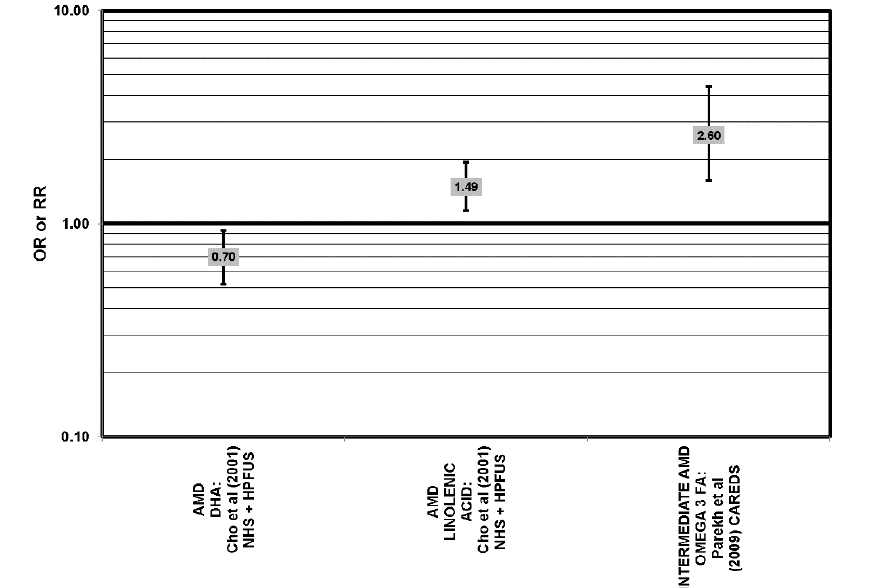
Figure 9. Odds or risk ratio for AMD or intermediate AMD; high vs. low intake of omega-3 fatty acids: prospective